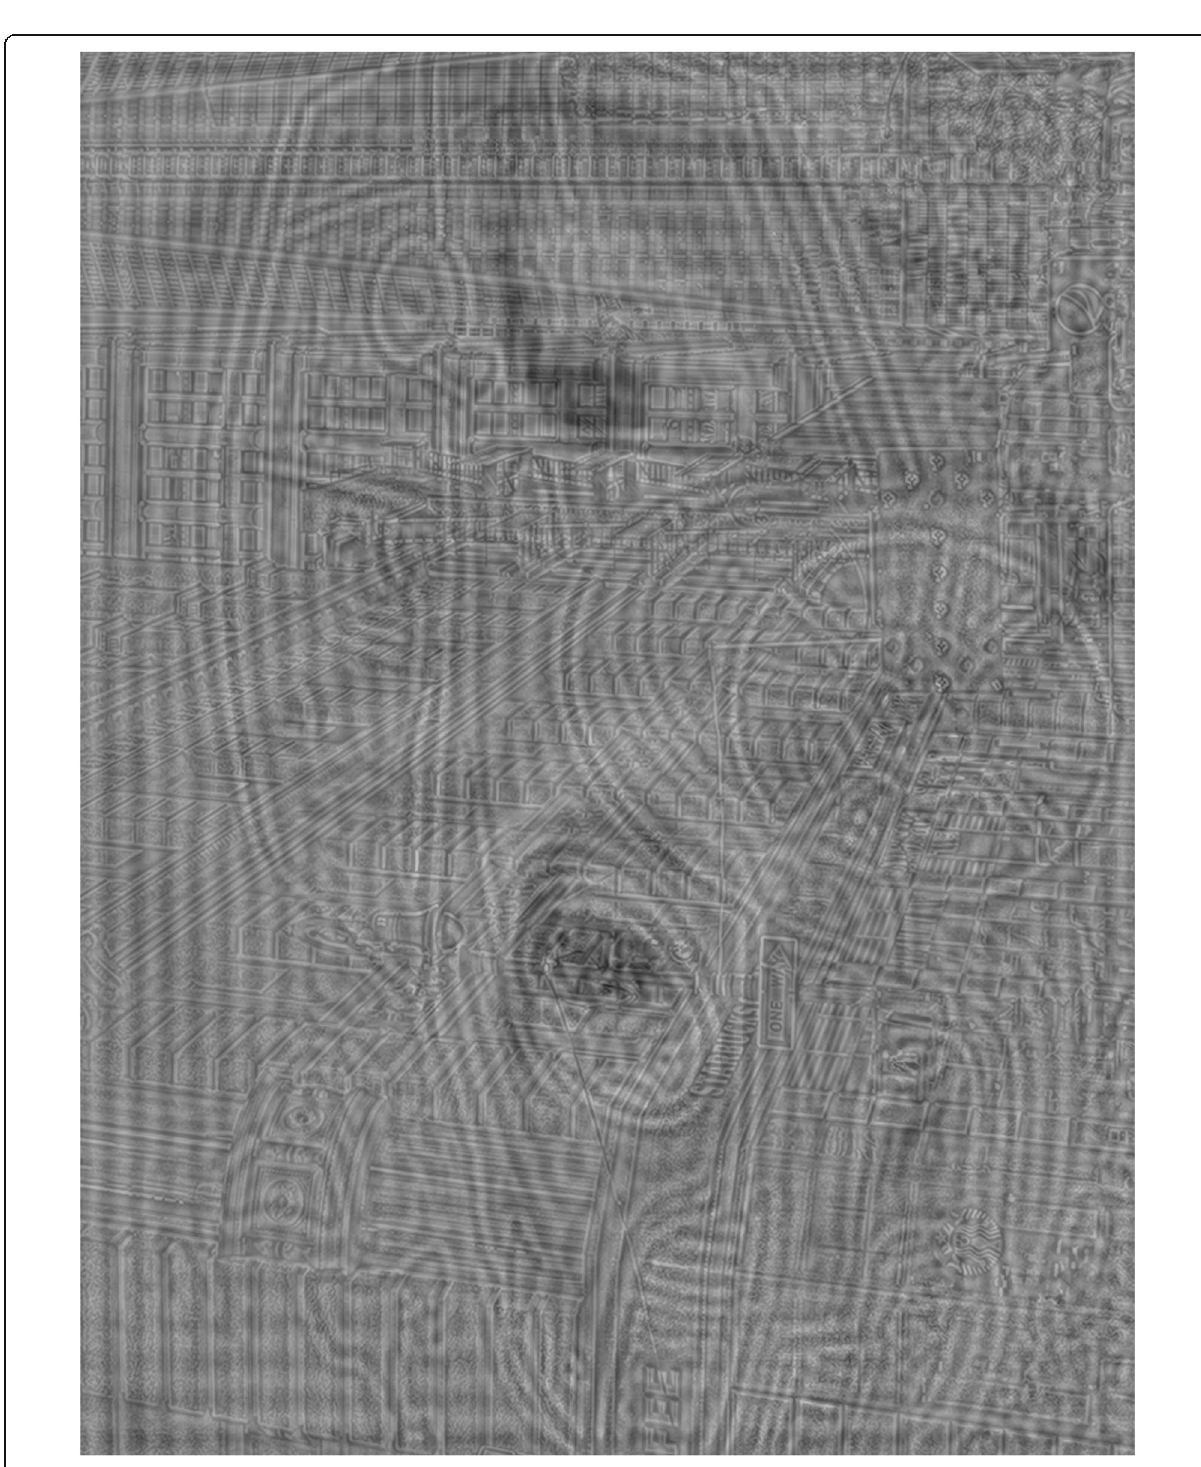
Fig. 3 A hybrid image of a city scene, a car, and a cat to be seen from near (30 cm or 26.56° of visual angle), middle (200 cm or 4.29° of visual angle) and far distance (500 cm or 1.72° of visual angle), respectively. This figure is rotated by 90 degrees to occupy as much space as possible. Source image: “ Maximum Mini ” ,© 2009 by Christian Senger, used under a Creative Commons Attribution license: [21], source image: “ Glass